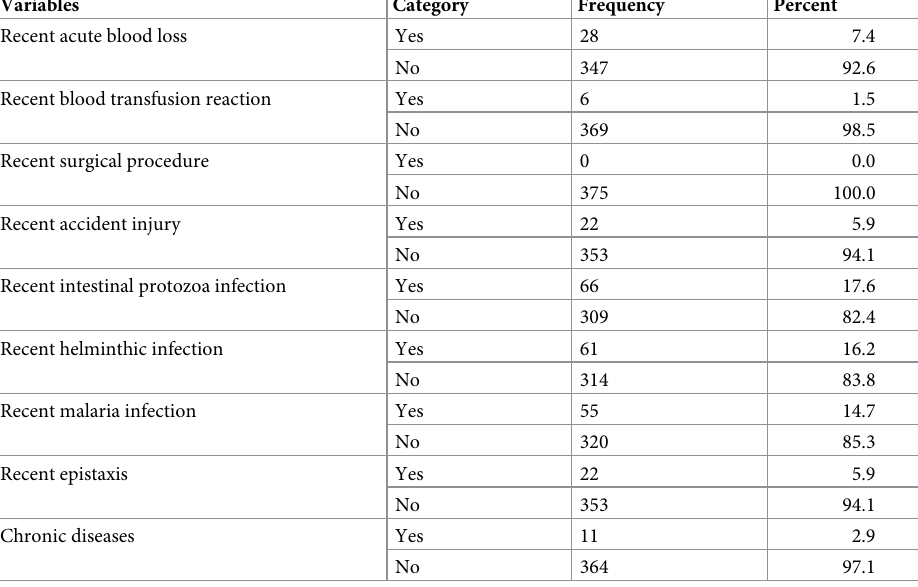
Table 3. Clinical characteristics of